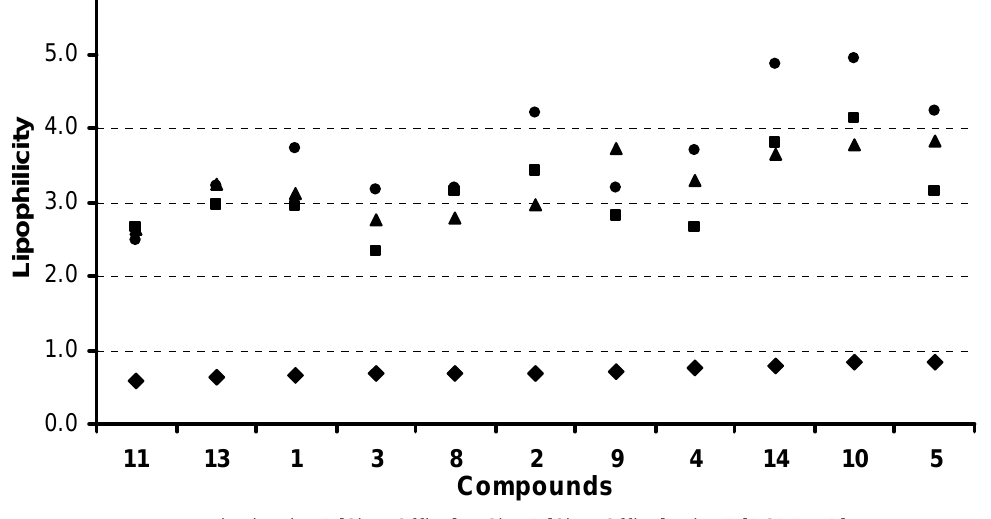
Figure 1. Comparison of the log P data calculated using the two programs with the experimentally found log k values. The compounds are arranged in the ascending manner according to the experimental log k